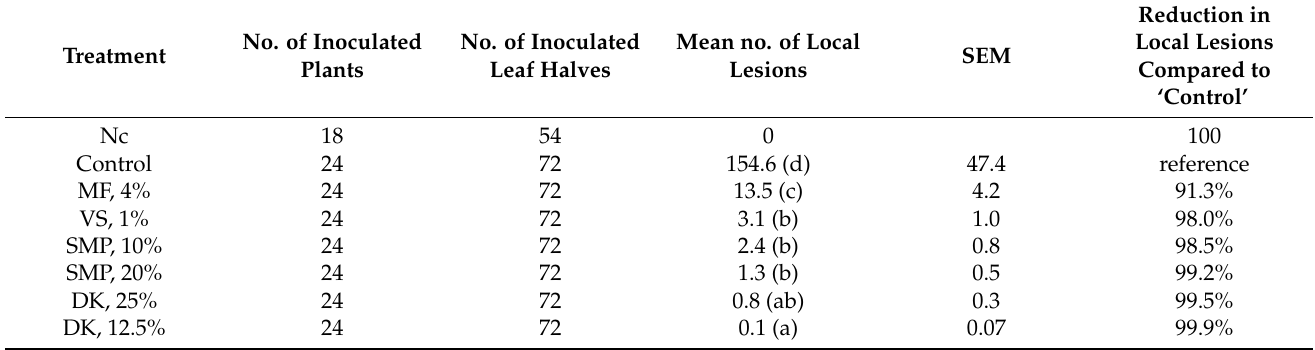
Table 4. Efficacy of selected disinfectants to inactivate ToBRFV in plant sap. Letters based on pairwise treatment comparisons using a generalized linear mixed model analysis of count data (alpha = 0.05, with Bonferroni